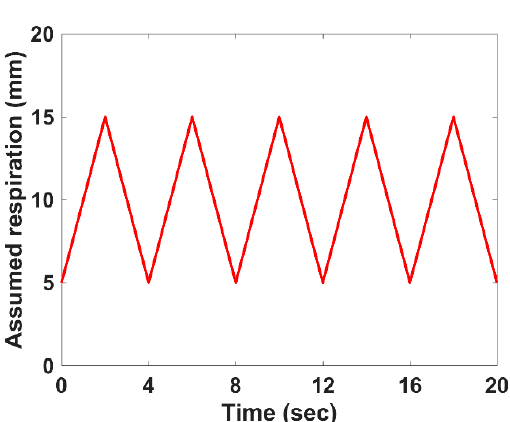
Figure 12. Assumed respiration versus time.